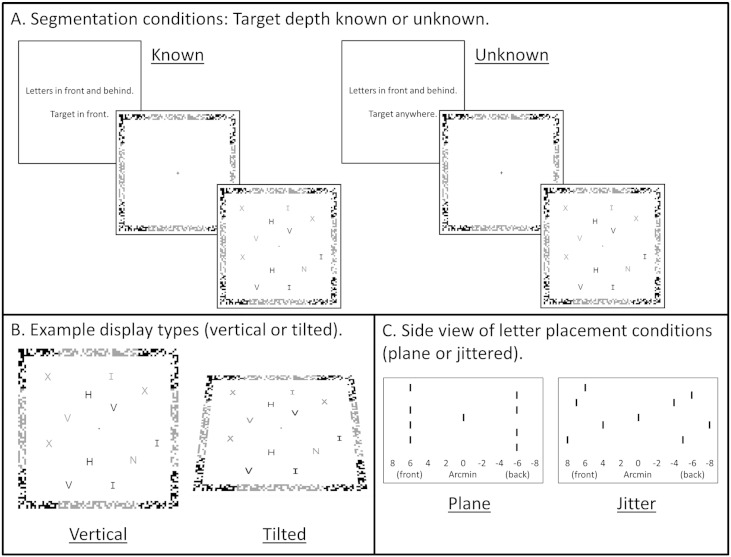
Experimental design. The task was to indicate if the display contained an N or a Z. Displays contained 8 or 16 letters. Light and dark grey indicate different depths (in front and behind fixation). Panel A. Example of the first three displays in each block. An initial screen instructs participants where stimuli will appear in that block (‘in front and behind’ or ‘on top and below’) and where the target will appear (‘target in front’, ‘target behind’, ‘target on top’, ‘target below’, ‘target anywhere’). Each trial then comprises a fixation screen and letter display. Panel B. Example vertical and tilted displays. Panel C. Side view to illustrate the plane and jitter letter placement conditions. The small lines indicate the placement in depth of letters and the fixation cross.